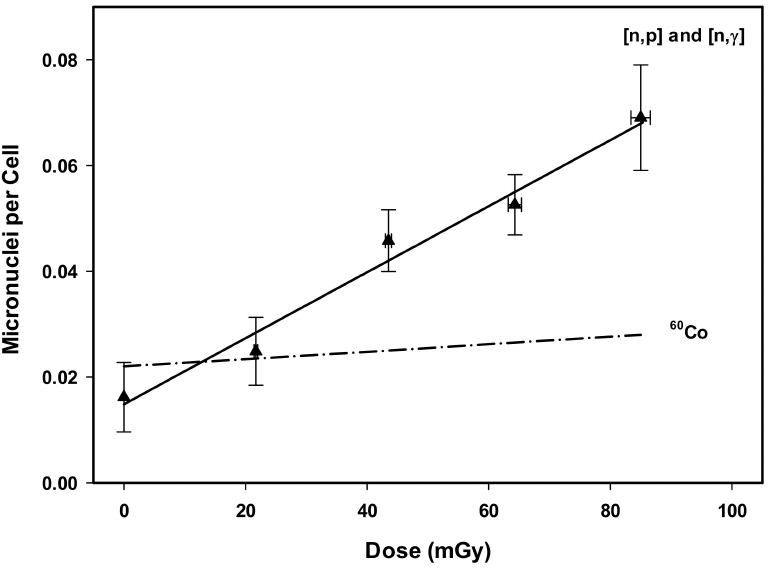
Figure 3. CBMN linear dose response regression (filled triangles, solid line) for 64 meV thermal neutron exposures compared to the extrapolated 60 Co curve (dash-dot line) generated from the linear quadratic dose response derived by McNamee et al. [30], detailing the relationship between radiation dose and the number of micronuclei per cell. Error bars represent standard error of the mean across three